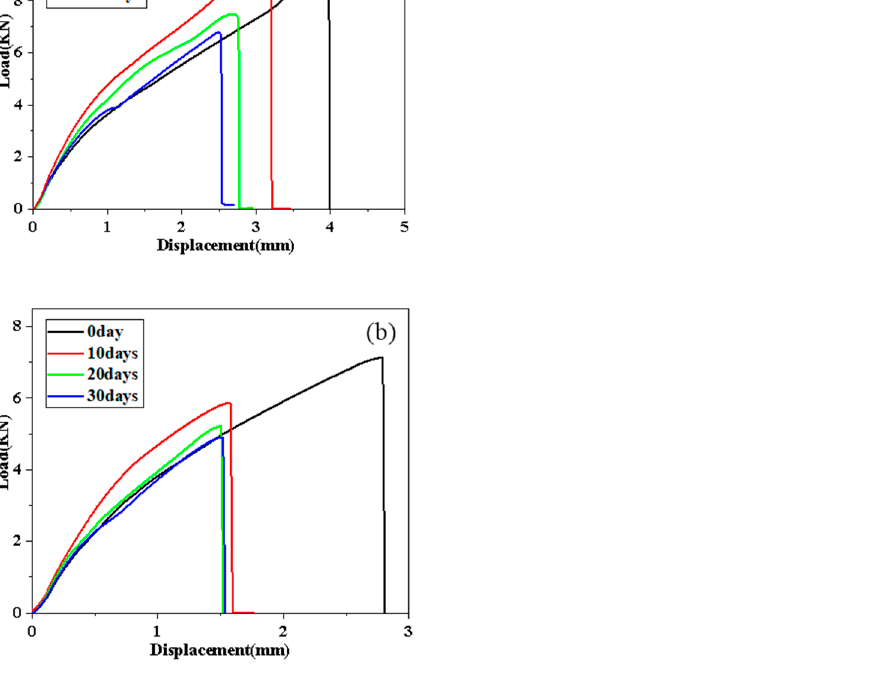
Figure 10. The most representative load displacement curves of different aging stages were obtained: ( a ) A2012-100% RH and ( b ) A2015-100% RH.